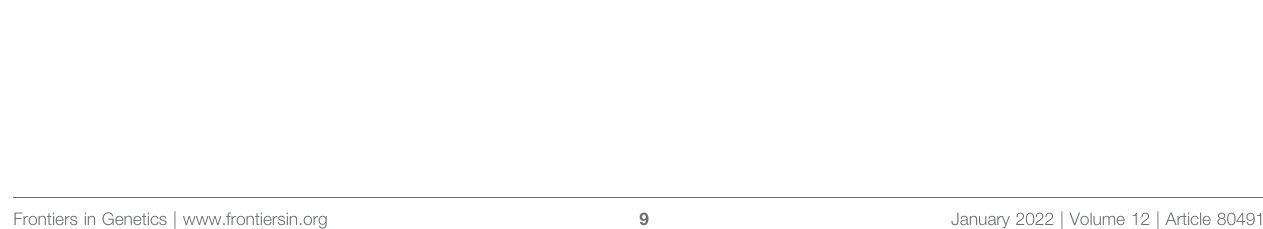
Frontiers in Genetics | www.frontiersin.org January 2022 | Volume 12 | Article 804916